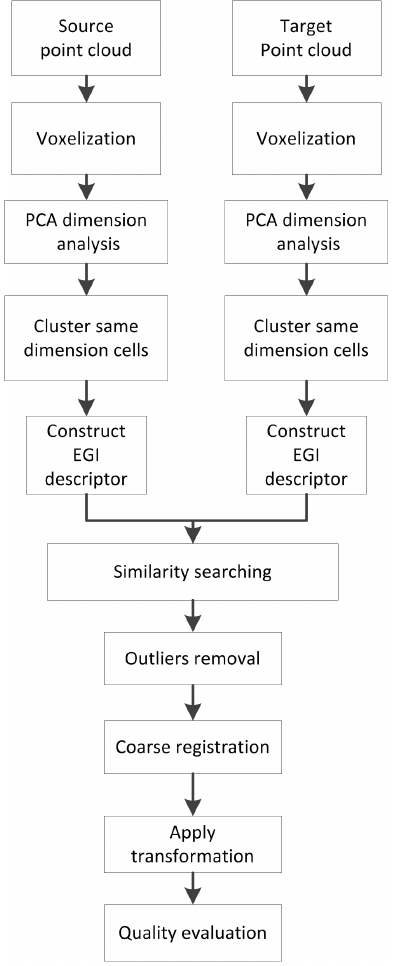
Figure 1: Overall methodology of the proposed coarse registra- tion clouds into voxel cells. Points inside each cell are analyzed and their dimension is obtained through PCA. Consecutively, cells